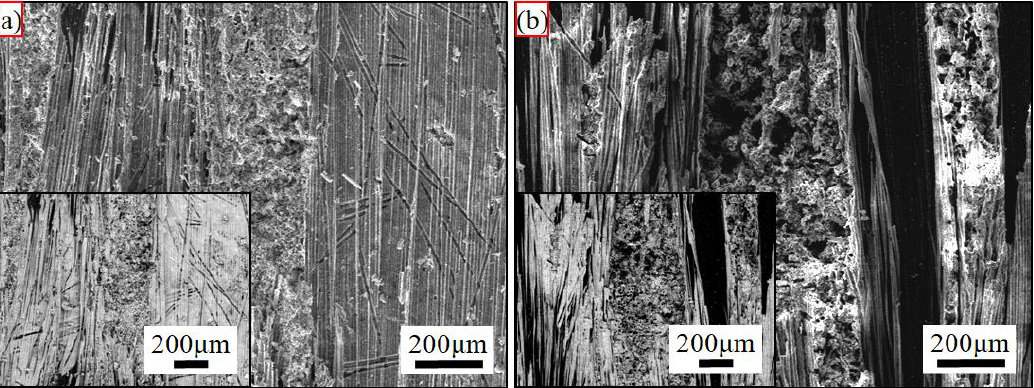
Figure 5. Surface morphologies of the ablated C/C-SiC-ZrC at low magnification: ( a ) under C 0.5 and ( b ) under C 5 ; the insert image at the corner is the corresponding backscattered electron morphology.